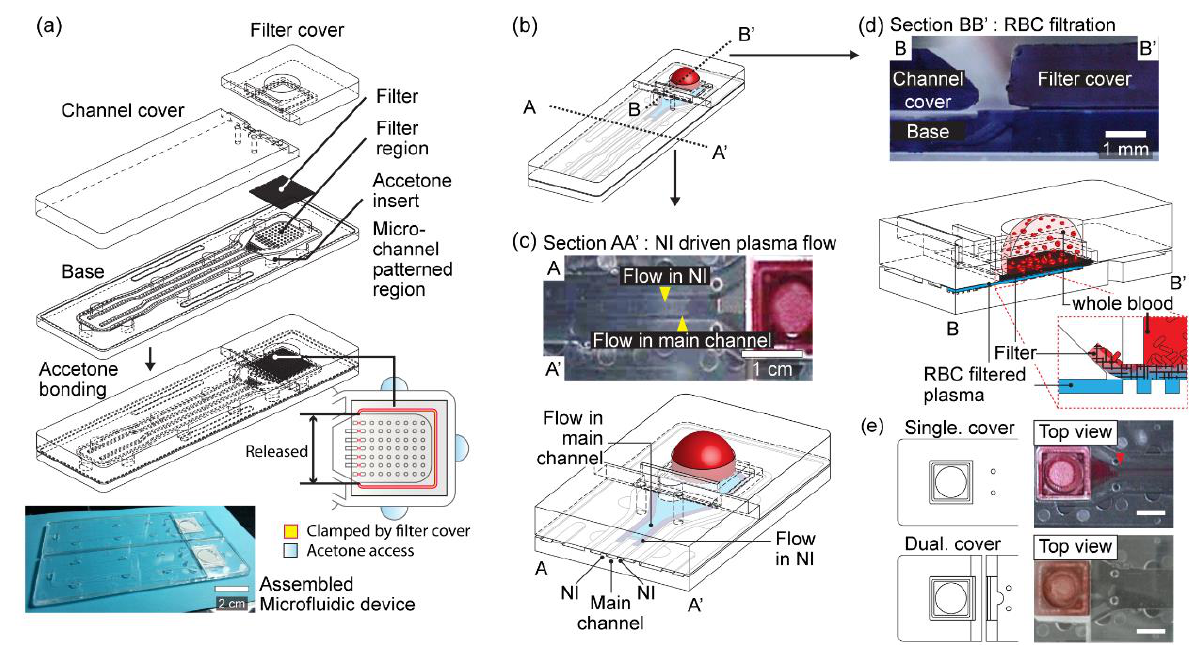
Figure 1. Overall illustration of the plasma separation microfluidic device with the dual cover. ( a ) Fabrication process of the device and the result of fabrication. ( b ) Application of whole blood on the device and feature of the device. ( c ) Section AA’ represents the process of plasma flow by the nano-interstice (NI)-driven flow. ( d ) Section BB’ indicates the mechanical prevention of red blood cell leakage by the dual cover system. ( e ) Whole blood application to single- and dual-cover devices. The red arrowhead indicates blood leakage. Scale bar, 4 mm.